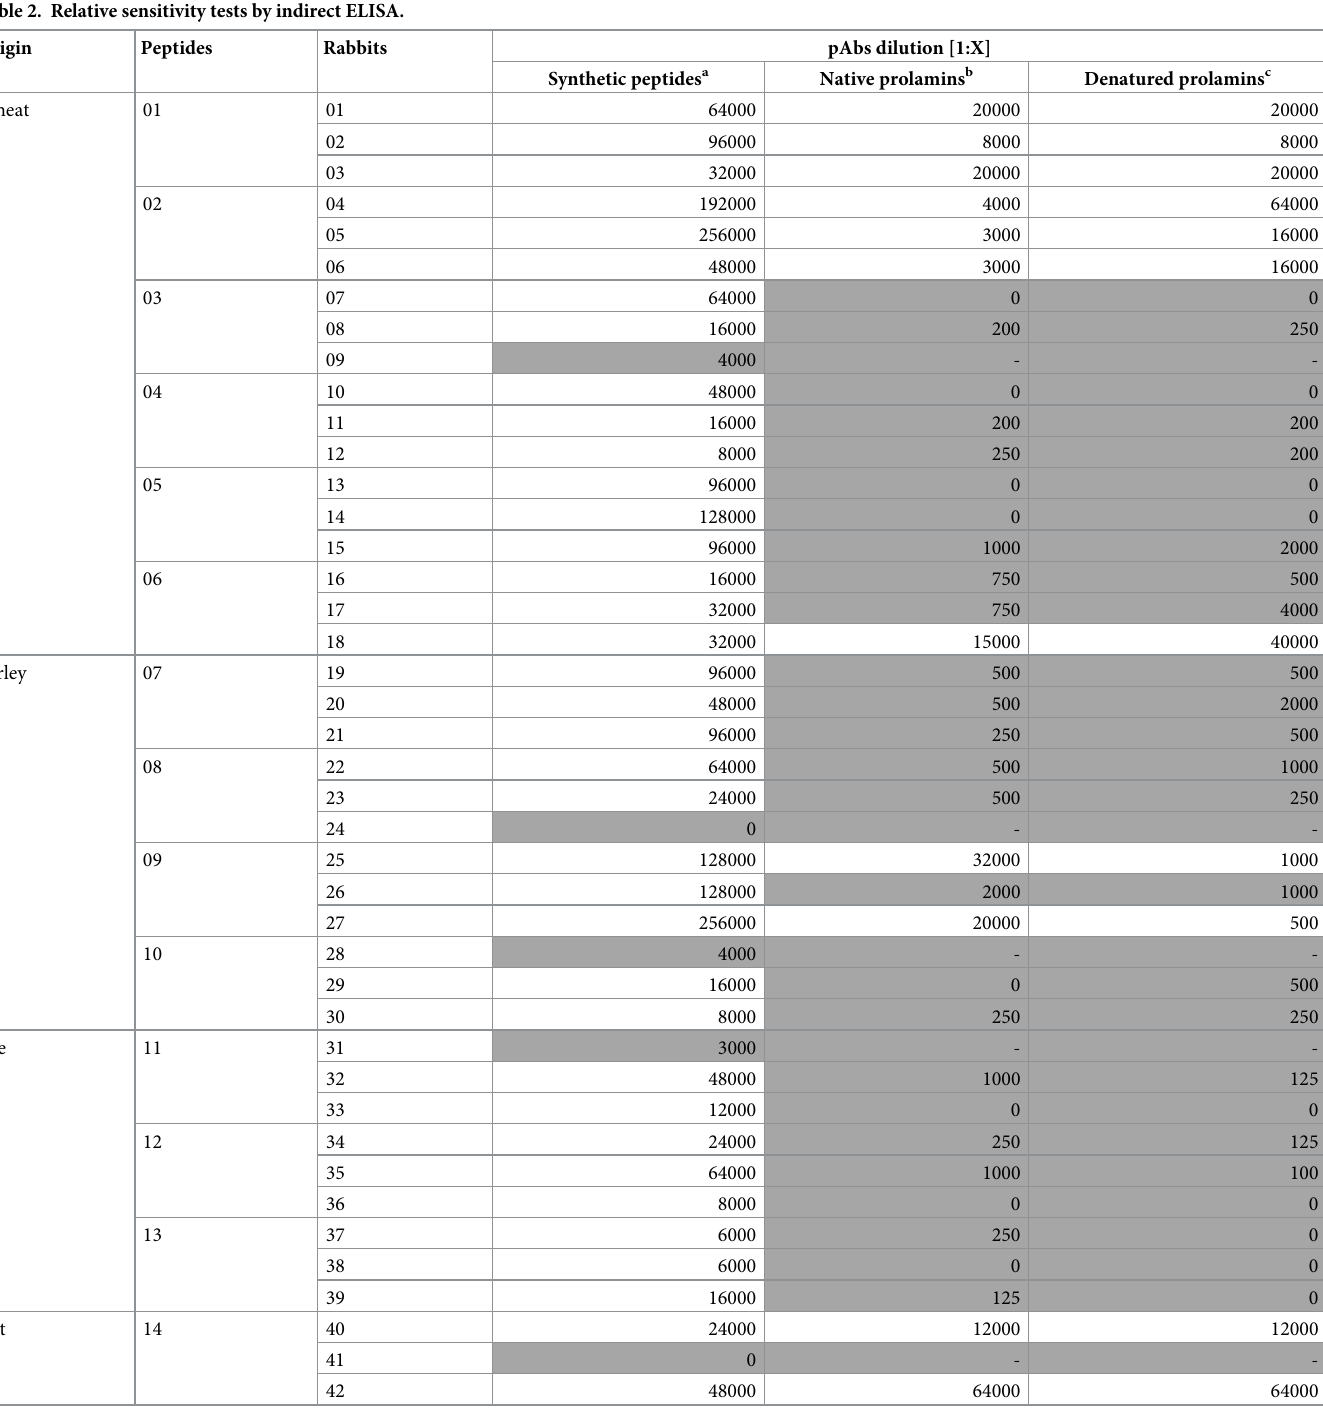
Table 2. Relative sensitivity tests by indirect